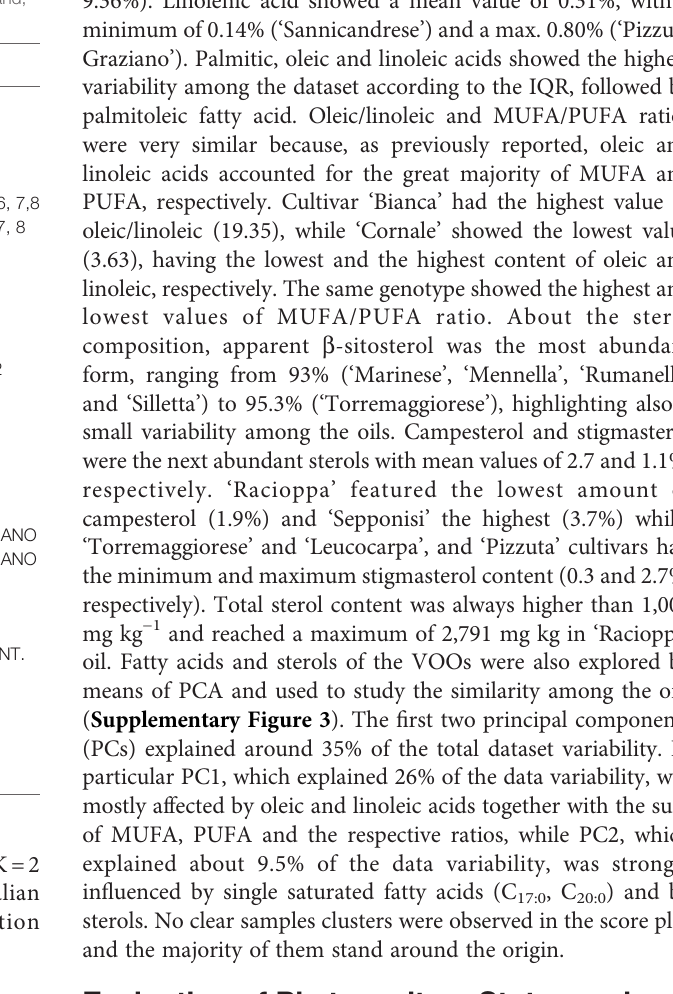
TABLE 4 | Cases of homonymies based on LRM estimator (Lynch and Ritland, 1999). Homonyms LRM <